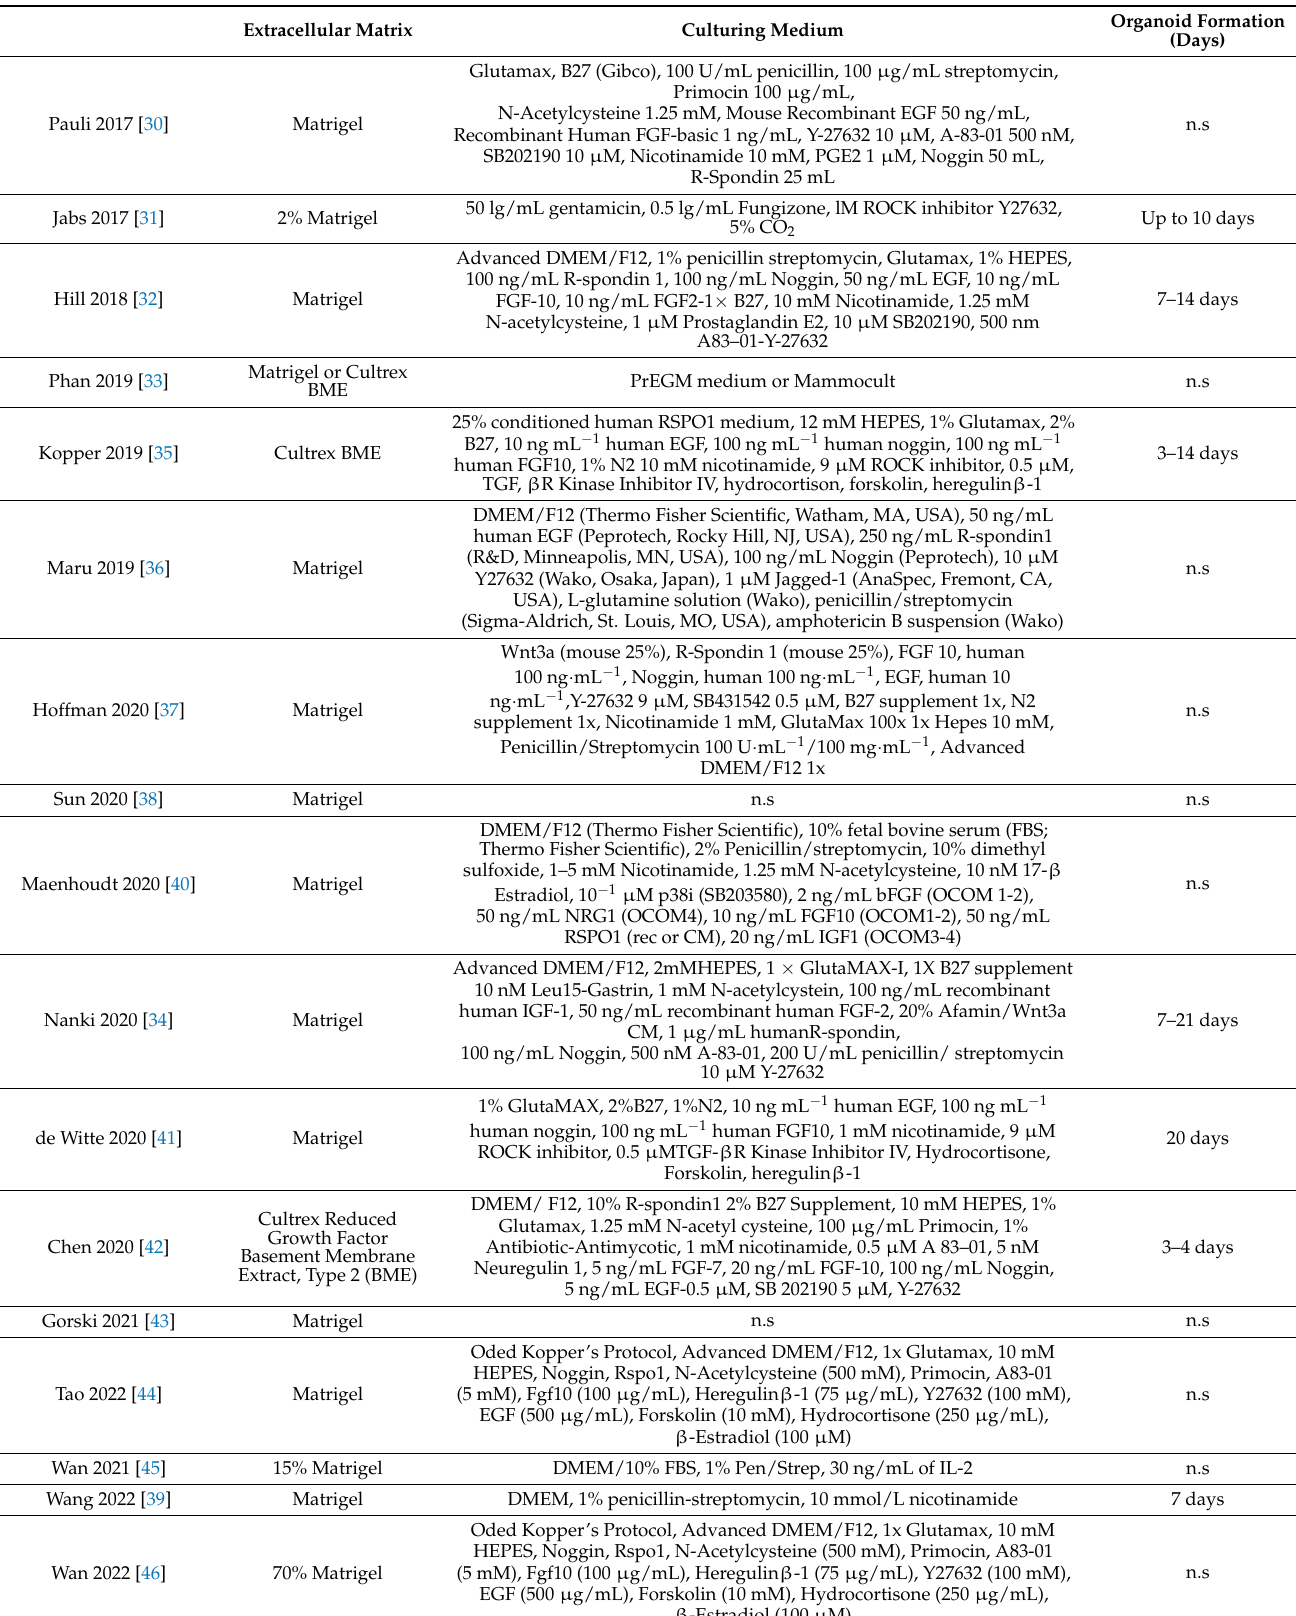
Table 2. Extracellular matrix